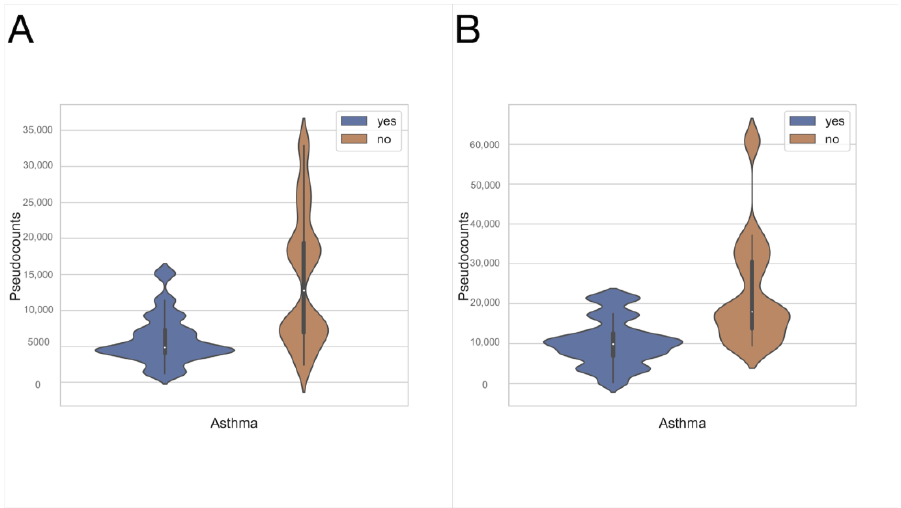
Figure 7. Relative abundance of differentially abundant taxa indicated by the ANCOM method, among EBC samples of asthmatics and healthy controls. The bacteria of class Bacilli (W = 1) ( A ) and Gammaproteobacteria (W = 1) ( B ) were more abundant in the group of asthmatics than in healthy controls.